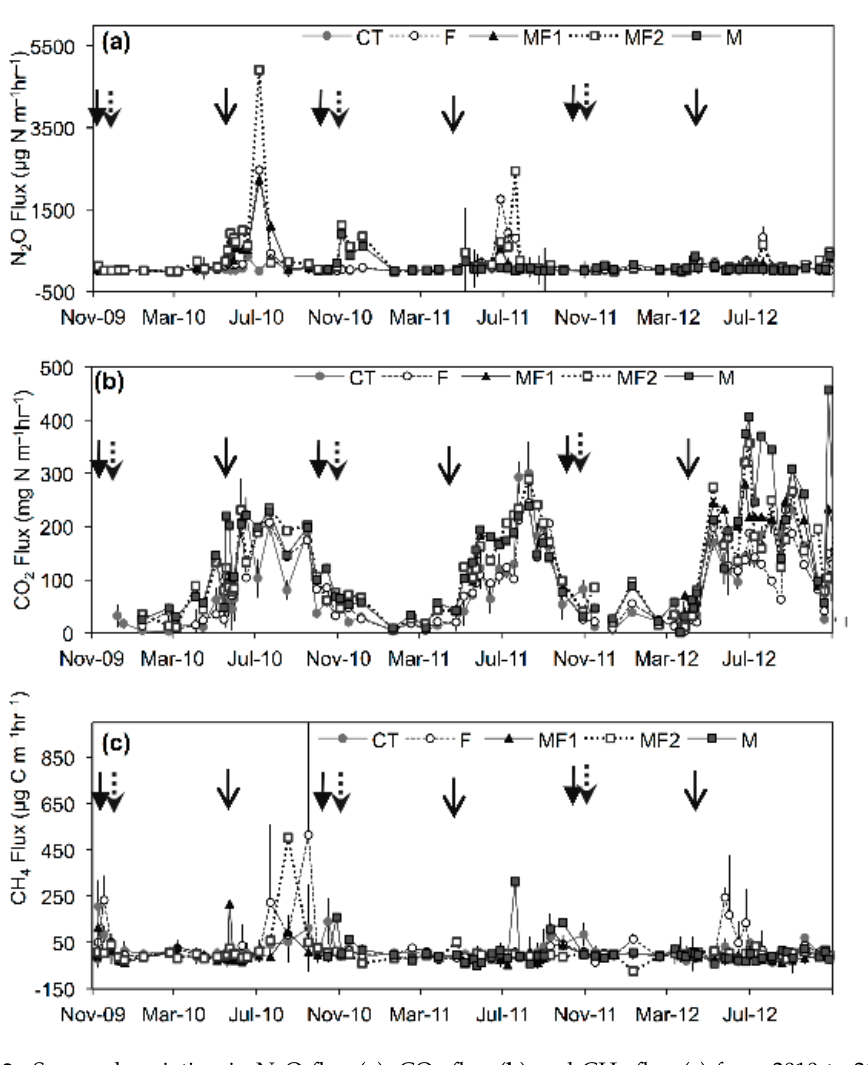
Figure 2. Seasonal variation in N 2 O flux ( a ), CO 2 flux ( b ) and CH 4 flux ( c ) from 2010 to 2012 in experiment 1. CT is unfertilized control plot; F is inorganic fertilizer ‐ only plot; MF1 is inorganic fertilizer plus composted cattle manure applied since 2005 plot; MF2 is inorganic fertilizer plus composted cattle manure applied since 2010 plot; M is composted cattle manure ‐ only plot. Full arrows with closed head indicate dates of manure application, dashed arrows indicate dates of ploughing; full arrows with open V shaped tip indicate dates of inorganic fertilizer application.